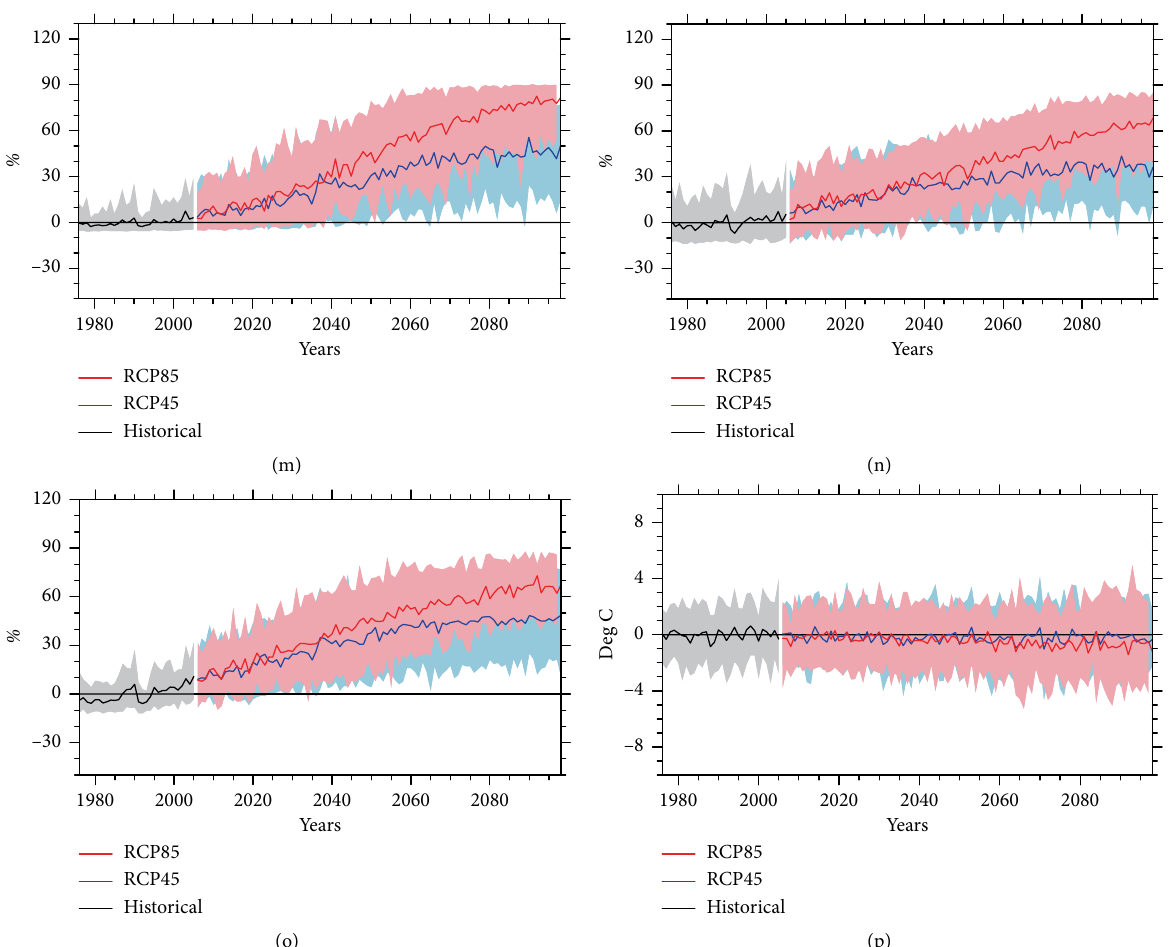
Figure 6: Long-term time series (1976–2100) of seasonal anomalies of HWFI (a, e, i, m), TX90P (b, f, j, n), TN90P (c, g, k, o) and ETR (d, h, l, p) during JFM (a, b, c, d), AMJ (e, f, g, h), JAS (i, j, k, l) and OND (m, n, o, p) seasons in Côte d’Ivoire over 1976–2005 period (grey) and both RCP4.5 (blue) and RCP8.5 (red) scenarios based on multi-model CORDEX-Africa simulations. The anomalies are calculated with respect to the mean value of the 1976–2005 period. The shaded areas denote ensemble 95 th and 5 th